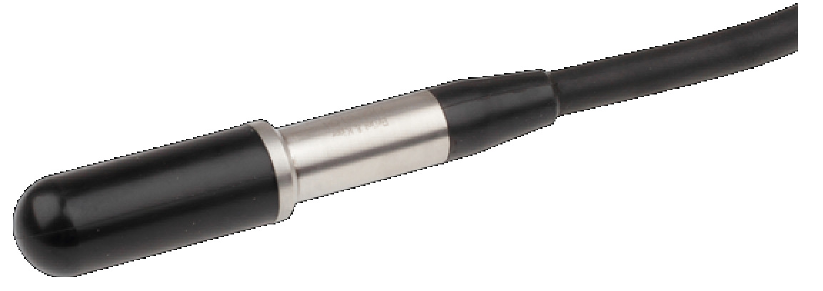
Figure 5. Bruel & Kjær Hydrophone Type